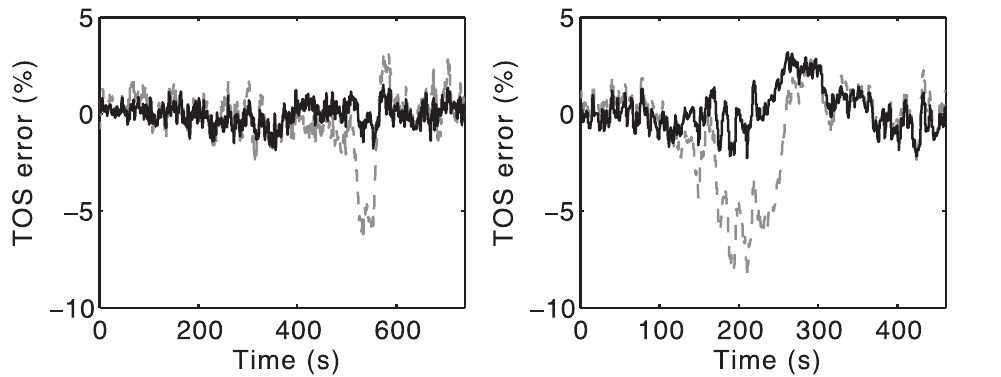
Figure 5. Error in predicted TOS during two challenges for Fit 1 and Fit 2. The TOS error is defined as TOS (model) - TOS (data). TOS error is shown following Fit 1 (dashed line) and Fit 2 (bold line) for two example challenges (Subject 2, challenge 1 and Subject 8, challenge 2). The plots illustrate that optimisation 2 considerably reduced the error in the prediction of TOS by reducing the expected drop in TOS during the hypoxemic challenge.